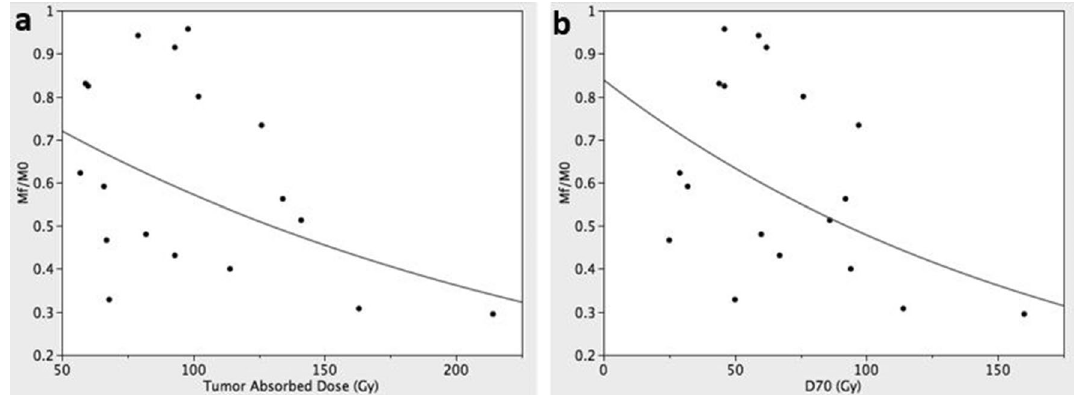
Figure 2. The logarithmic correlation of the residual tumor mass expressed in percentage (M f /M 0 ) with tumor absorbed dose (r 2 = 0.24, p < 0.04) ( a ) and D70 (r 2 = 0.24, p < 0.04) ( b